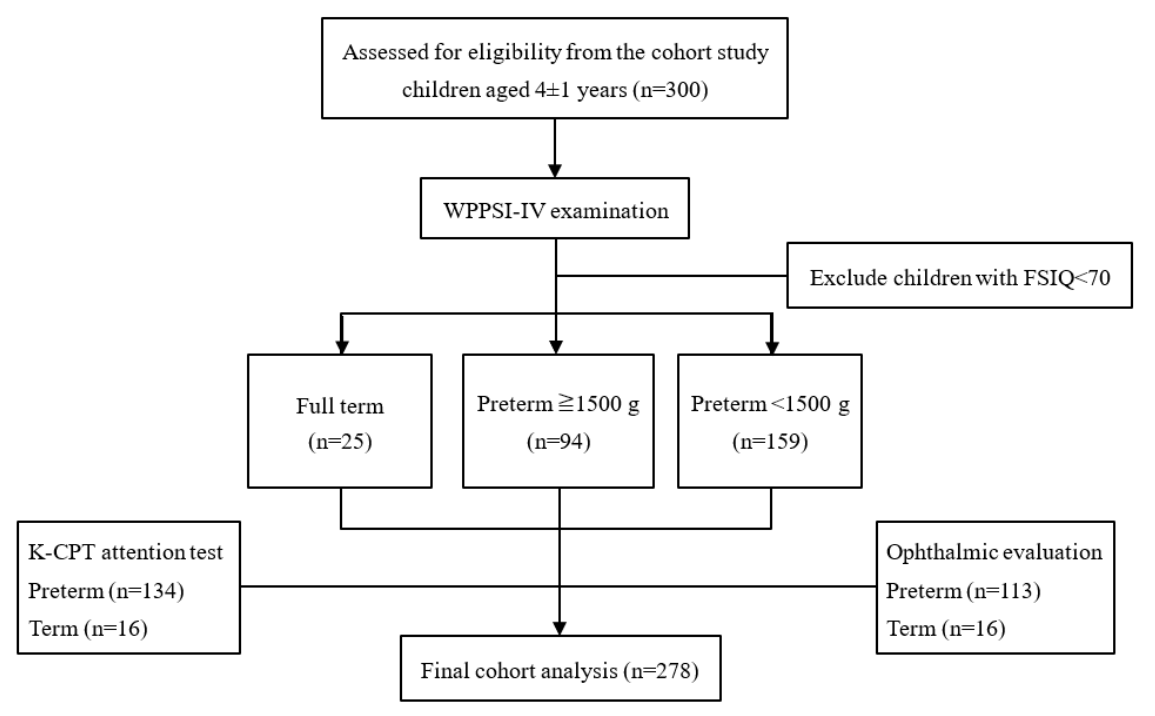
Figure 1. Flow chart of the study protocol. WPPSI: the Wechsler preschool and primary scale of intelligence, Fourth Edition; FSIQ: full-scale intelligence quotient; K-CPT: Conners Kiddie Continuous Performance Test.